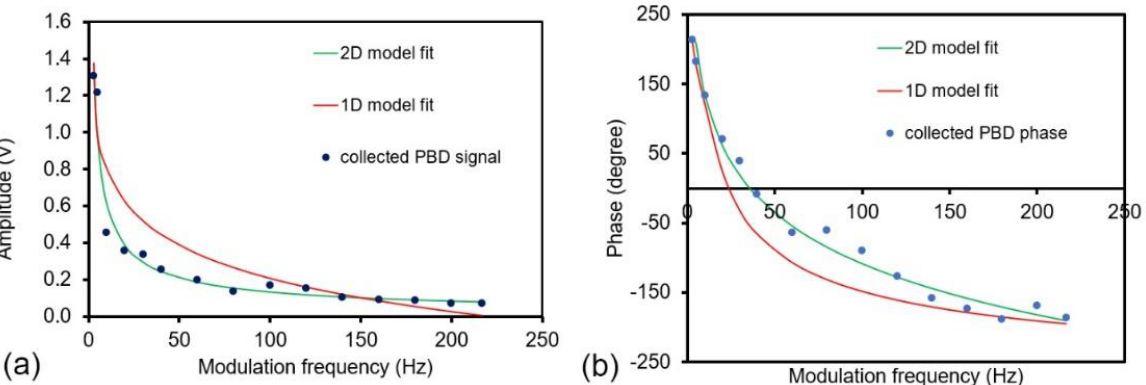
Figure 4. Variations in the ( a ) amplitude and ( b ) phase of the PBD signal with respect to the modulation frequency of PuB, for the case of PuB focussed, along with the fitting curves using 1D and 2D models.